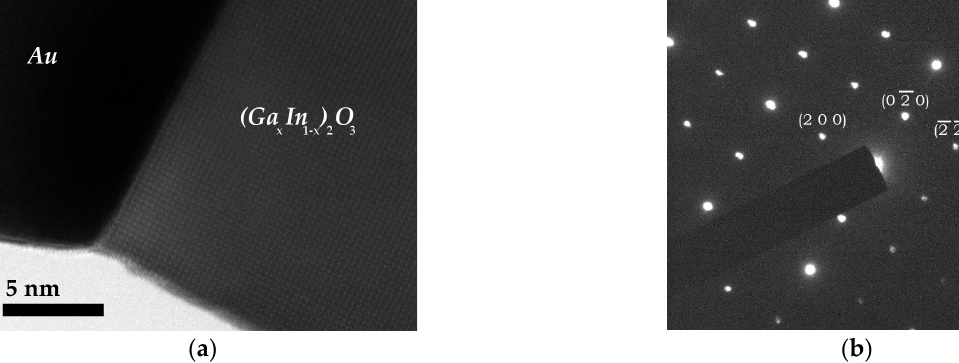
Figure 5. ( a ) High resolution TEM image of the interface between NW of the Sample A and its gold tip and ( b ) the corresponding diffraction pattern of the NW, with some of its peaks indexed. The diffraction pattern is coherent with cubic In 2 O 3 , observed along its zone axis [001].